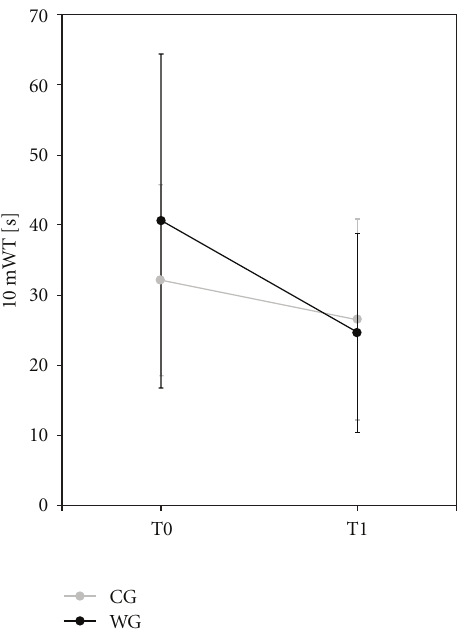
Figure 1: Mean and standard deviation of the time spent to walk for 10 m by Walkaide group (WG, black) and control group (CG, grey).